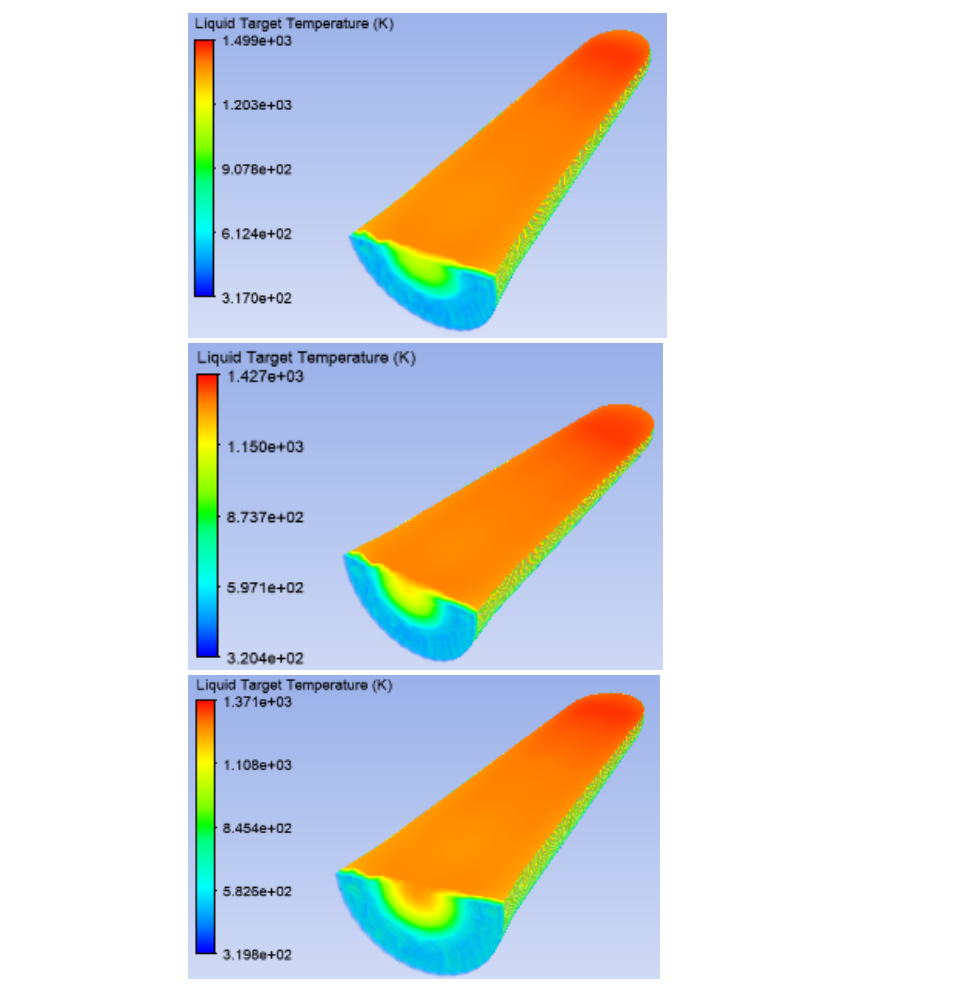
Figure 21. Temperature of the liquid target for niobium target windows of 75, 125, 250, 325, and 375 µm (from top to bottom ).